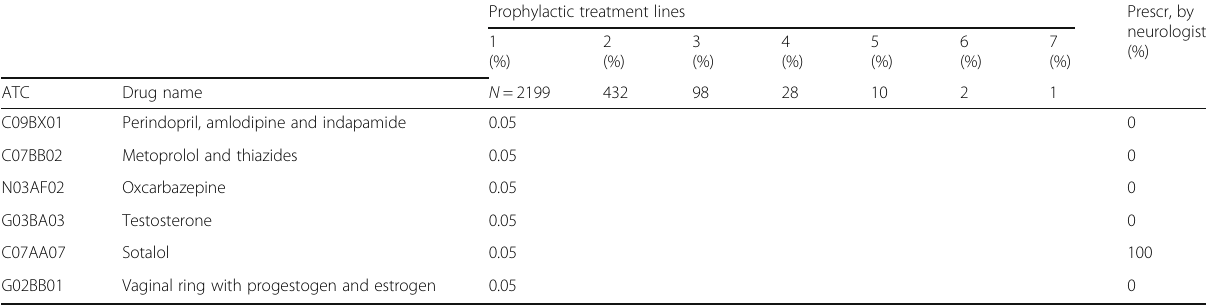
Table 3 Prophylactic treatment lines of patients with G43*diagnosis and the word migraine in the free text of a prophylactic migraine prescription. A new treatment line was defined as a new drug prescription